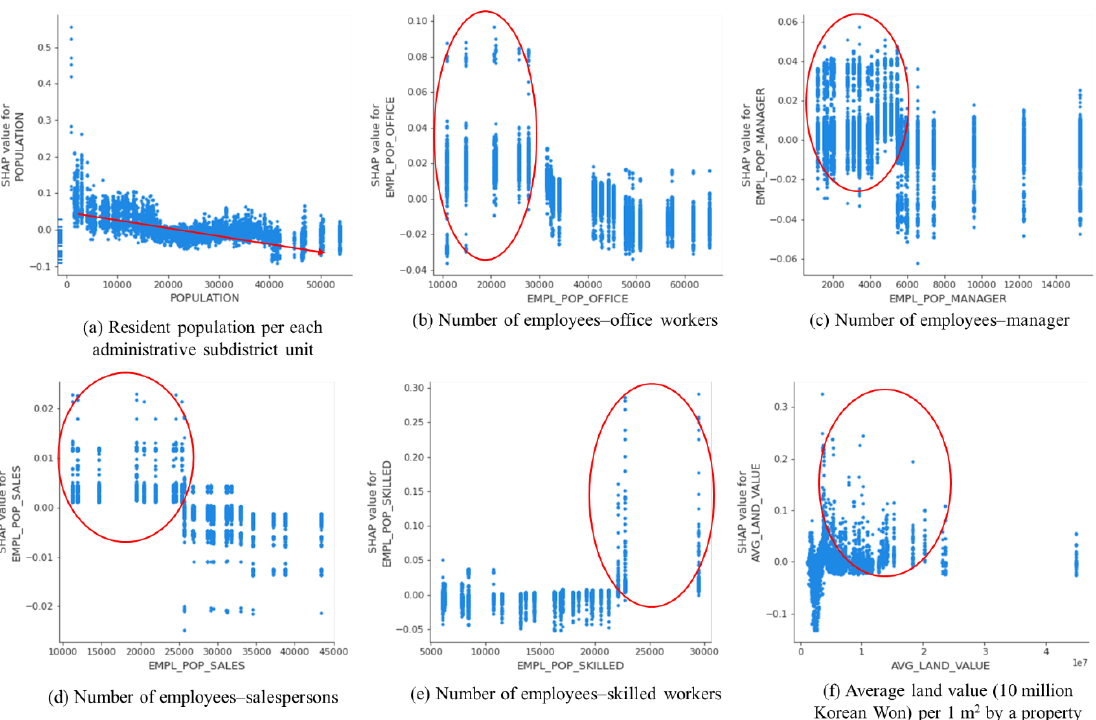
Figure 6. Dependence plots for six features from the socio-economic category.